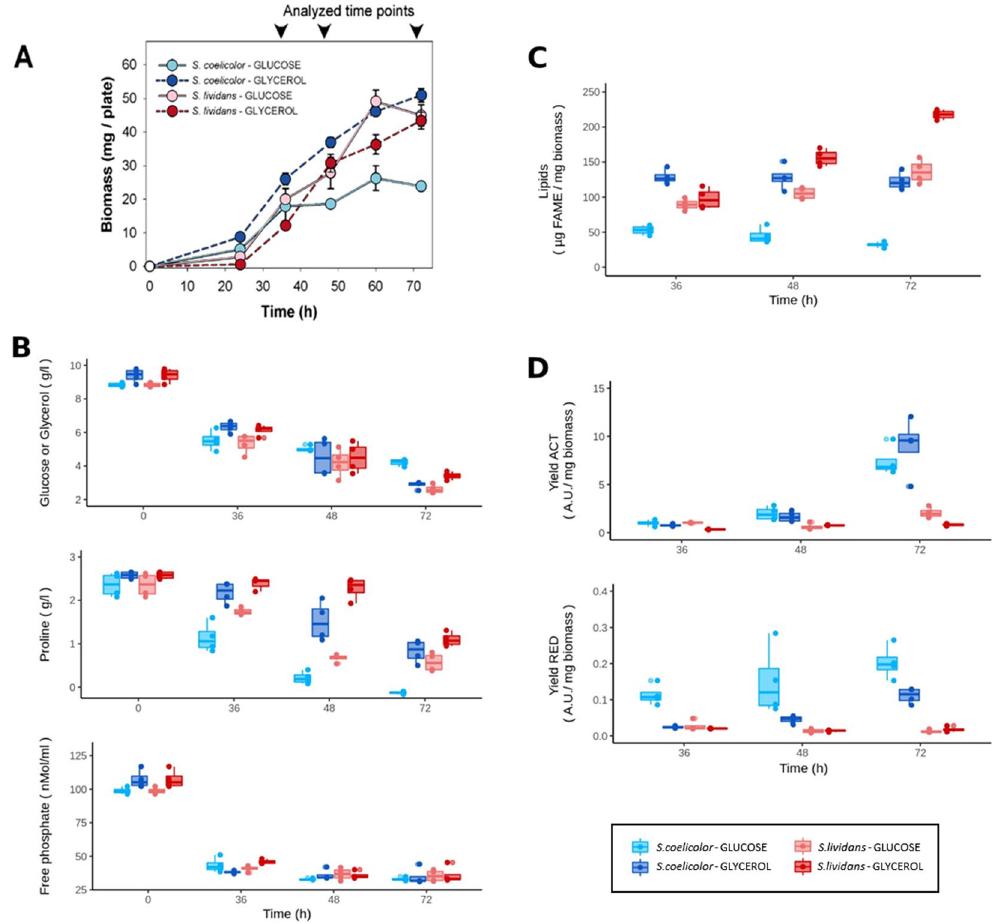
Figure 1. Cultures of S. lividans (TK24) and S. coelicolor (M145) grown on solid R2YE limited in phosphate (1 mM) with either glucose (50 mM) or glycerol (100 mM) as main carbon source for 36, 48 and 72 h at 28 °C. Growth curves of S. lividans and S. coelicolor grown on glucose and glycerol (A) . Concentration of glucose, proline and free phosphate in the growth medium (B) . Content in Fatty Acid Methyl Esters (FAME) (C) . Quantification of ACT and RED yields (D)